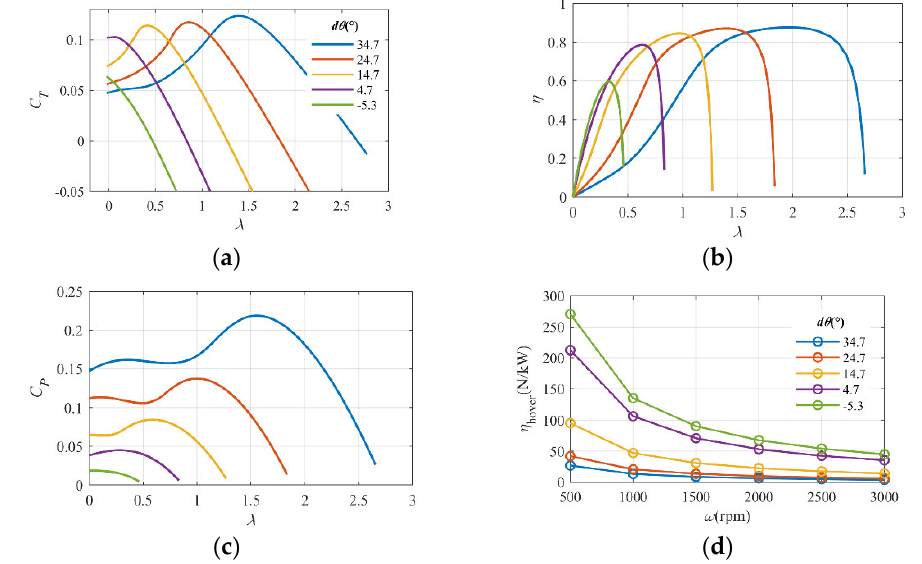
Figure 18. Performance of the selected optimal VPP. ( a ) .